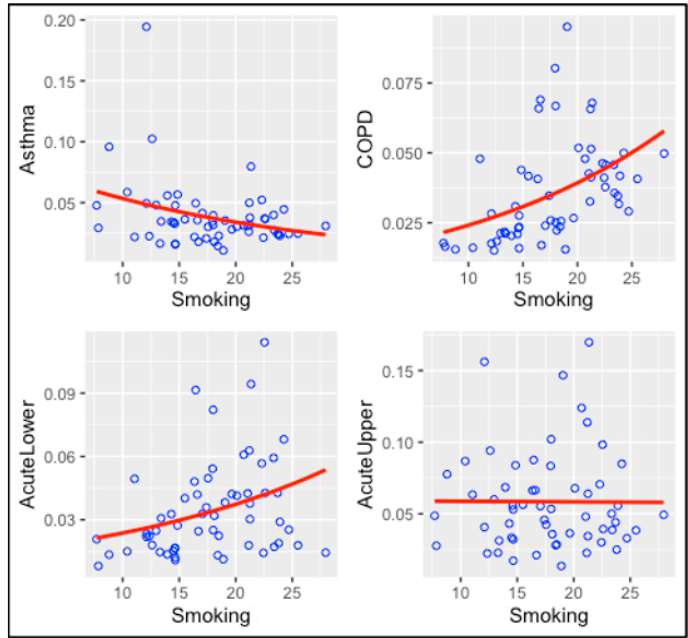
Figure 6. The associations between smoking and respiratory diseases. Table 4. The associations between smoking and respiratory diseases .